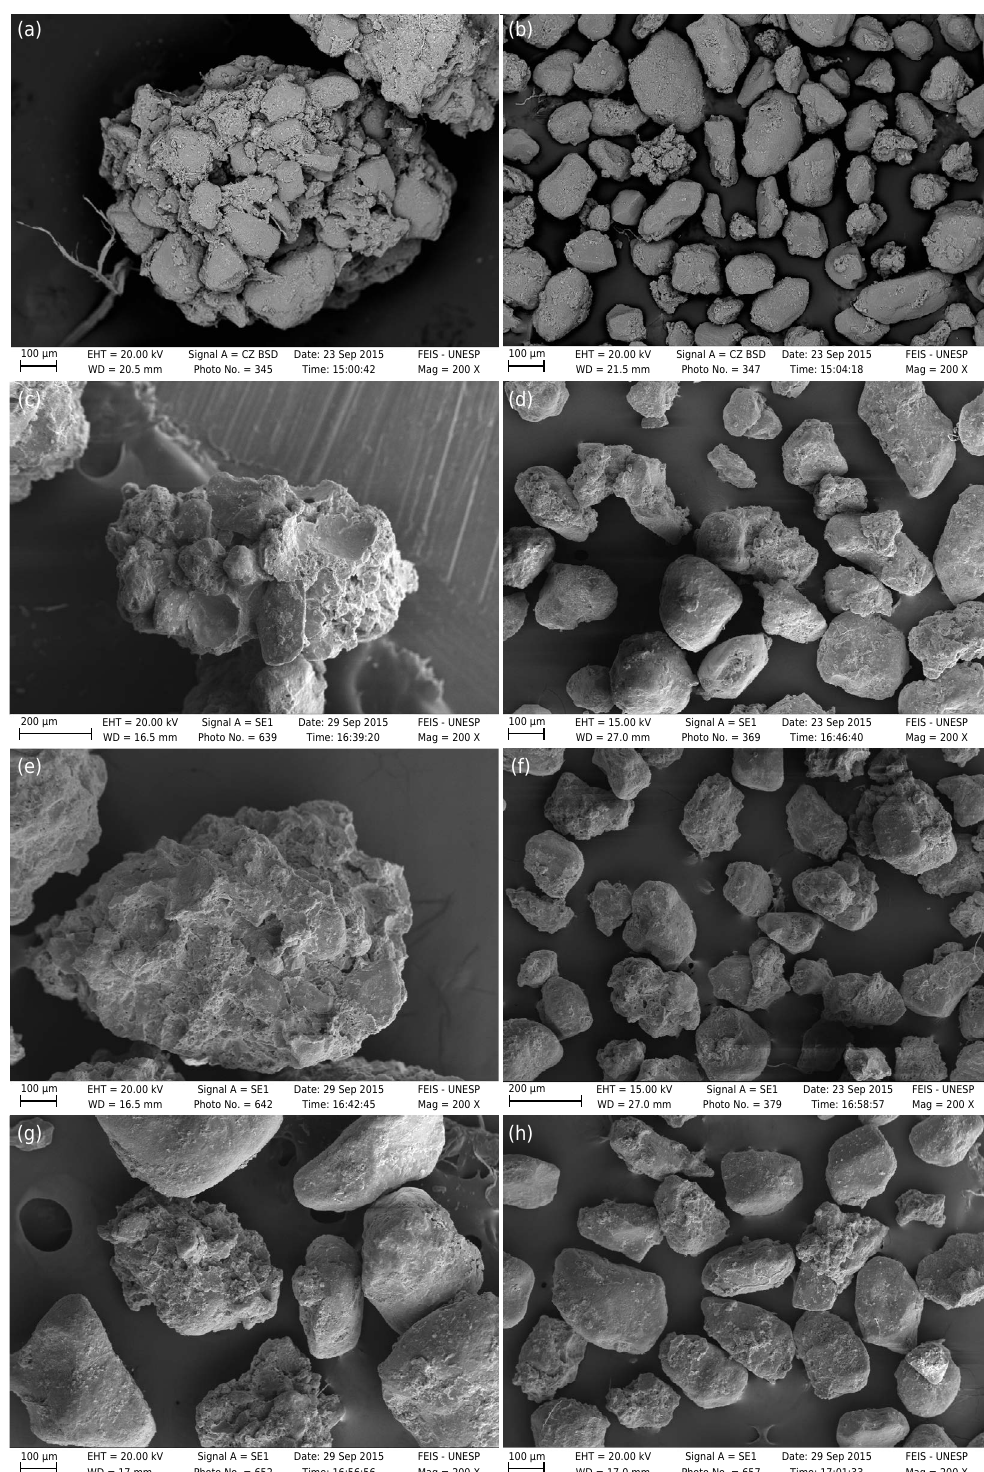
Figure 2. Scanning electron microscopy (SEM) images of the aggregates with a diameter from 0.50-1.00 and 0.05-0.10 mm in the 0.0-0.05 m layer under different land use systems [preserved Cerrado - CER, 15-year-old Eucalyptus - EU15, 2 year-old Eucalyptus - EU02, and Pasture - PAST). (a) CER: diameter 0.50-1.00 mm; (b) CER: diameter 0.05-0.10 mm; (c) EU15: diameter 0.50-1.00 mm; (d) EU15: diameter 0.05-0.10 mm; (e) EU02: diameter 0.50-1.00 mm; (f) EU02: diameter 0.05-0.10 mm; (g) PAST: diameter 0.50-1.00 mm; (h) PAST: diameter 0.05-0.10